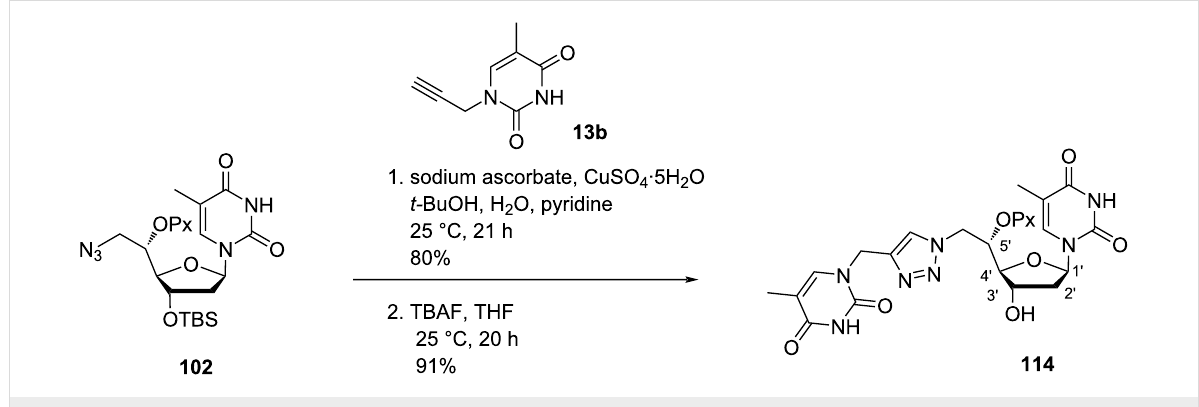
Scheme 27: Synthesis of double-headed nucleoside 114 by click reaction.